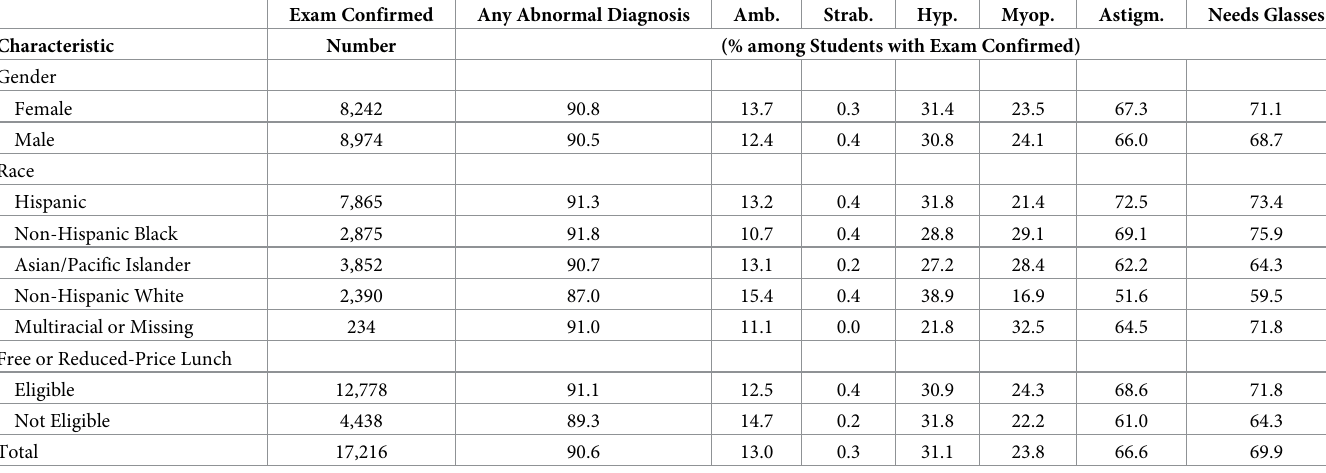
Table 5. Rates of abnormal diagnoses by student characteristics, among students in Pre-K through 1 st grade,